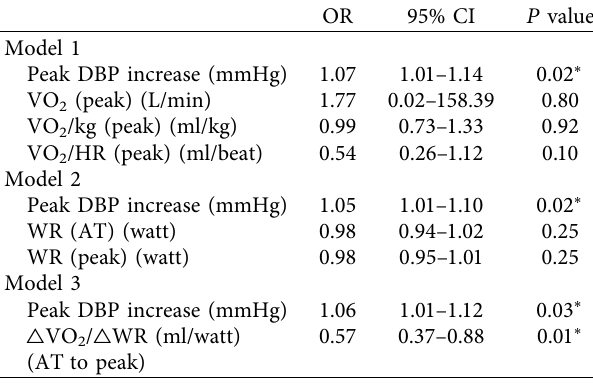
Table 6: Binary logistic regression analysis of EH-ATP in hy- pertensive patients during